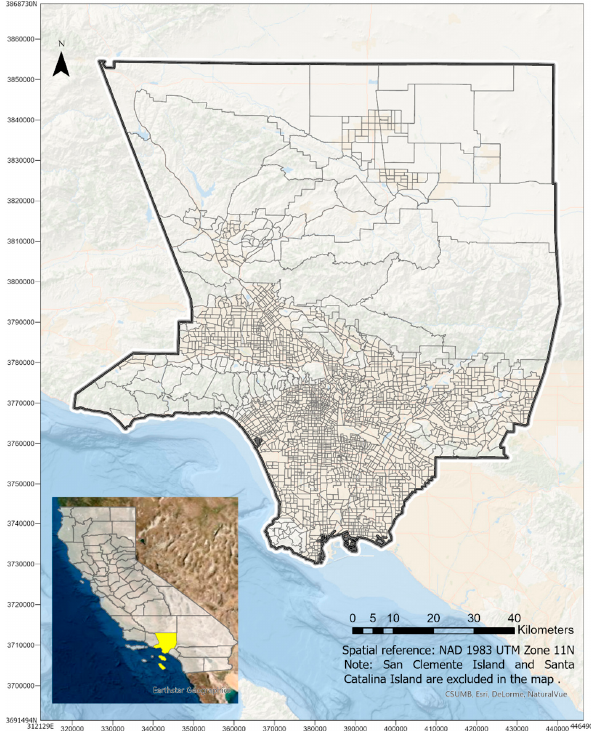
Figure 1. Los Angeles County census tracts and